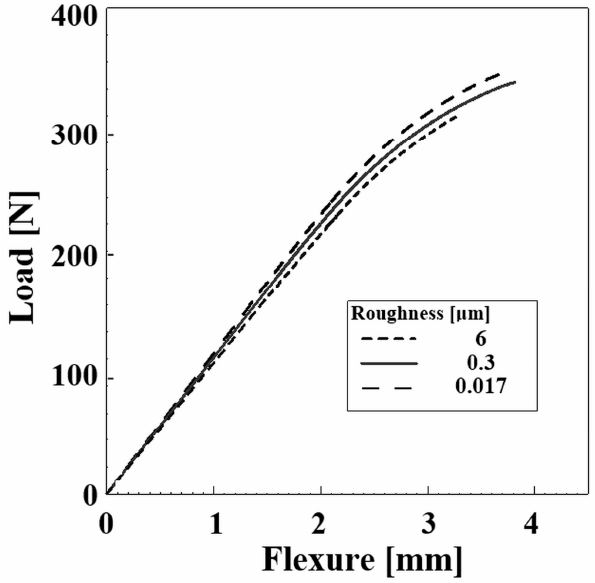
Figure 4. Load–flexure diagrams of the specimens with different surface roughness.